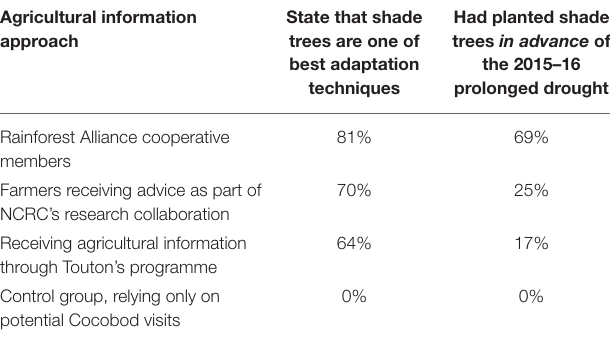
TABLE 4 | Percentage of farmers—in each of the four agricultural information profiles—who (middle column) suggested that maintaining shade trees is one of the best adaptation techniques, and who (rightmost column) had actually planted shade trees as an anticipatory adaptive action against extreme weather and climate change pressures before the 2015–16 extended